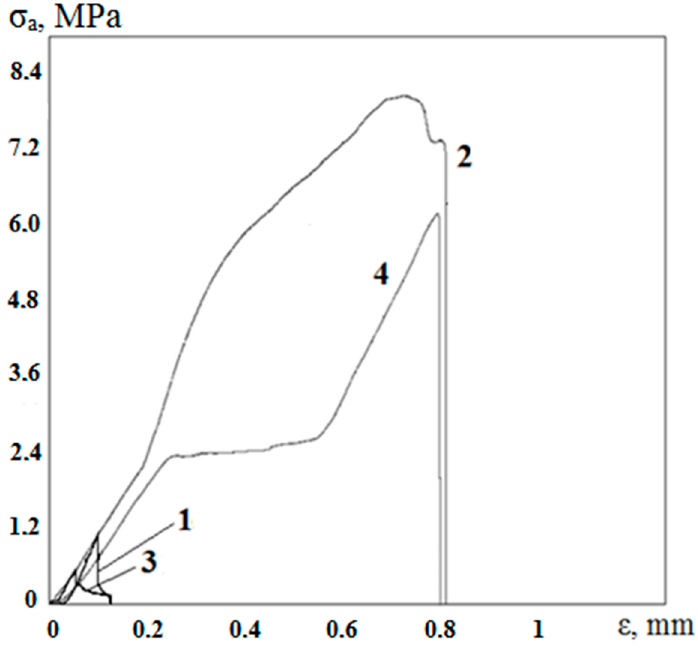
Figure 9. Results of adhesion strength testing (series 1–4).